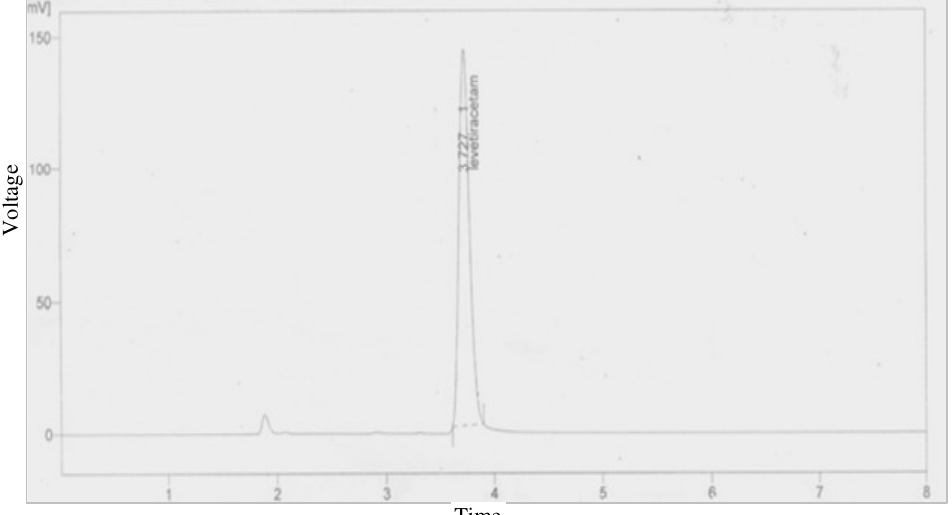
Figure 1. Typical chromatogram of